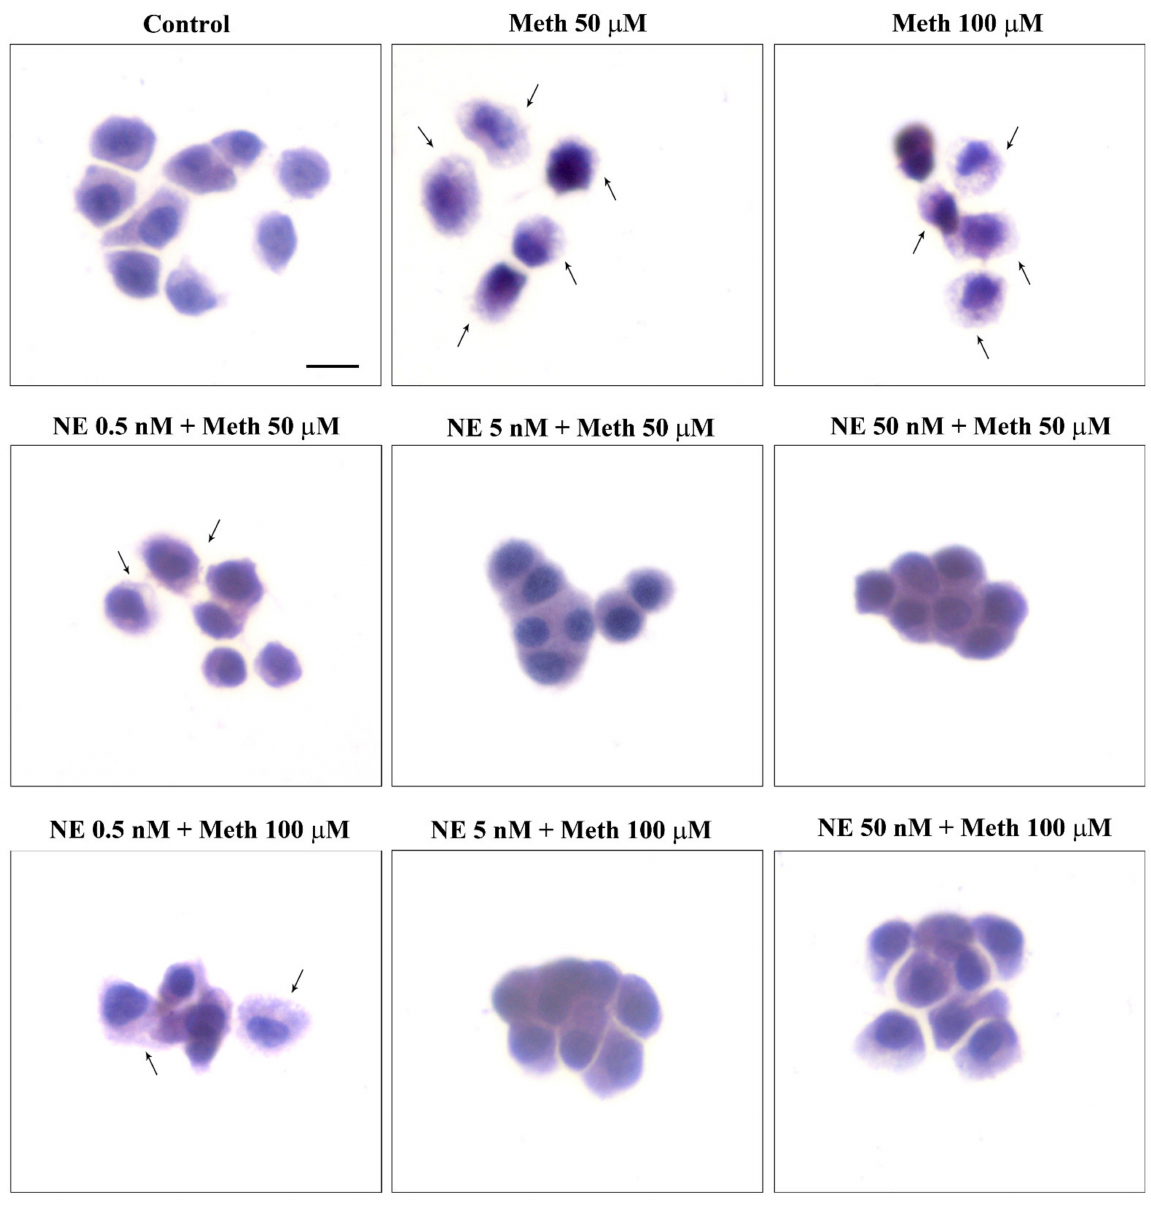
Figure 2. NE does protect against Meth toxicity (H&E staining). Representative pictures show NE protection against Meth-induced toxicity. The protective effects of NE are evident both at the dose of 5 nM and 50 nM administered to cells treated with Meth either at the dose of 50 µ M or 100 µ M. The toxic effects of Meth are detectable in spared cells as pale eosinophilic cytosol (arrows) where damaged cells are abnormal in size and shape. Scale bar = 8 µ